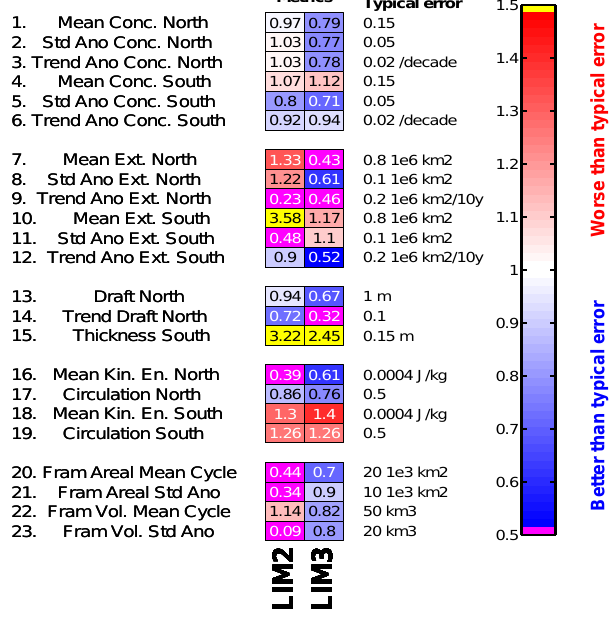
Table 2. Summarizing metrics for the two simulations described in Sect. 2. The metrics in this table result from the scaling of model errors (defined in Sect. 3) by a specified typical error. Lower values indicate better skill, and a simulation is skillful for a certain feature if its metrics corresponding to this feature is lower than 1. See the text of Sect. 3 for complete description of the 23